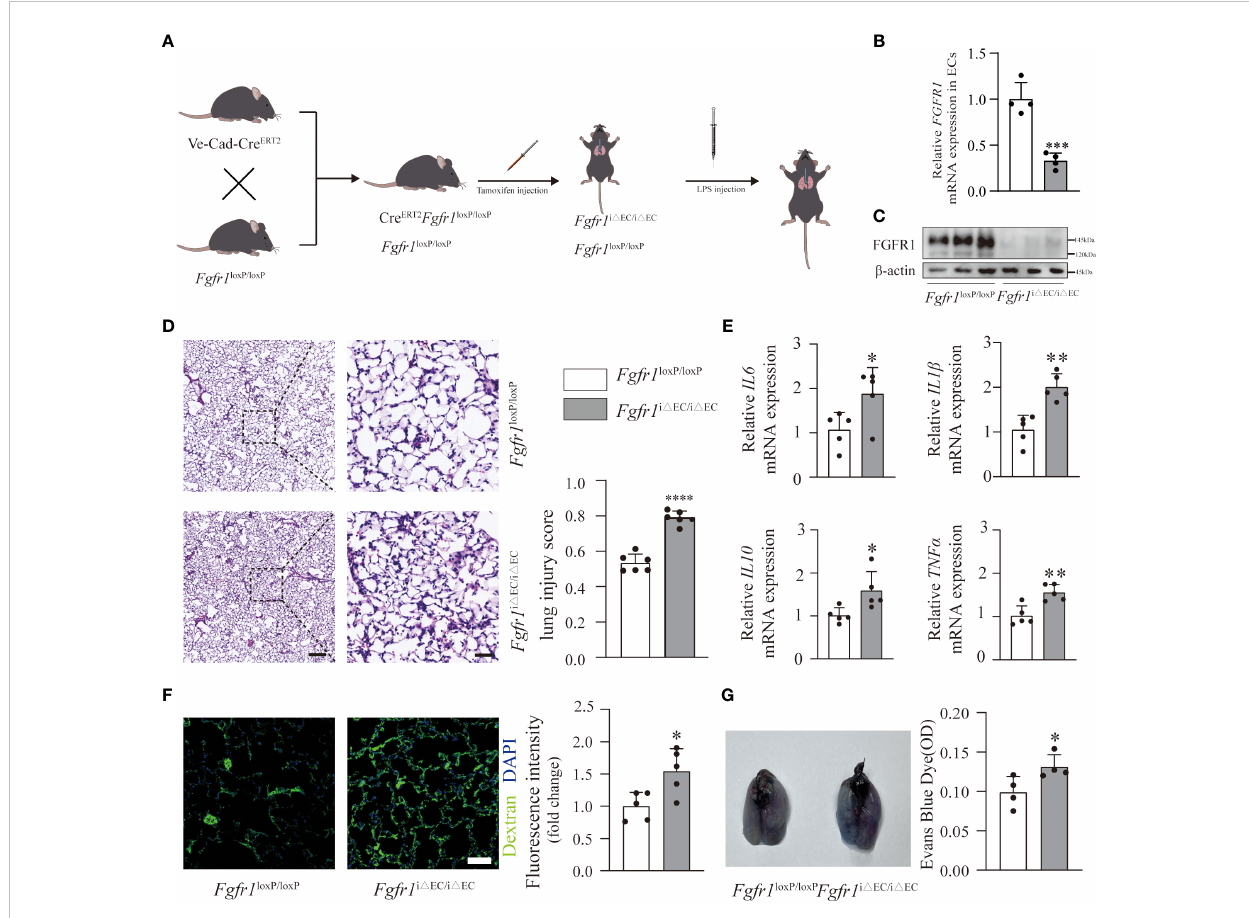
FIGURE 2 Deletion of FGFR1 in ECs aggravated the severity of in fl ammation and vascular leakage. Fgfr1 i D EC/i D EC mice and Fgfr1 loxP/loxP mice were intraperitoneally injected with tamoxifen. After LPS injection, ALI/ARDS was established (A) . Knockout ef fi ciency of endothelial cell-speci fi c deletion of FGFR1 is shown. RT-PCR analysis of endothelial FGFR1 mRNA in Fgfr1 loxP/loxP mice and Fgfr1 i D EC/i D EC mice (B) . n=4 per group. Western blotting analysis of endothelial FGFR1 in Fgfr1 loxP/loxP mice and Fgfr1 i D EC/i D EC mice (C) . n=3 per group. Lung sections were examined for signs of in fl ammation after hematoxylin and eosin staining and were scored for lung injury (D) . n=6 per group. Scale bars: 200 µm (left) and 40 µm (right). Signi fi cantly higher lung injury scores (D) and higher relative mRNA levels of in fl ammatory cytokines ( IL6 , IL1 b , IL10 , TNF a ) (E) suggested aggravated lung in fl ammation in Fgfr1 i D EC/i D EC mice. n=5 per group. Vascular permeability was assessed by extravasation of FITC-dextran (F) and EBD (G) . Representative images of immuno fl uorescent staining and quanti fi cation of the mean fl uorescence intensity of FITC-dextran are shown (F) . n=5 per group. Scale bars: 50 µm. Representative images of the gross appearance of EBD-stained lungs and quanti fi cation of EBD content in the lungs are shown (G) . n=4 per group. Each bar represents the mean ± SD; *p < 0.05, **p < 0.01, ***p<0.001 and ****p <